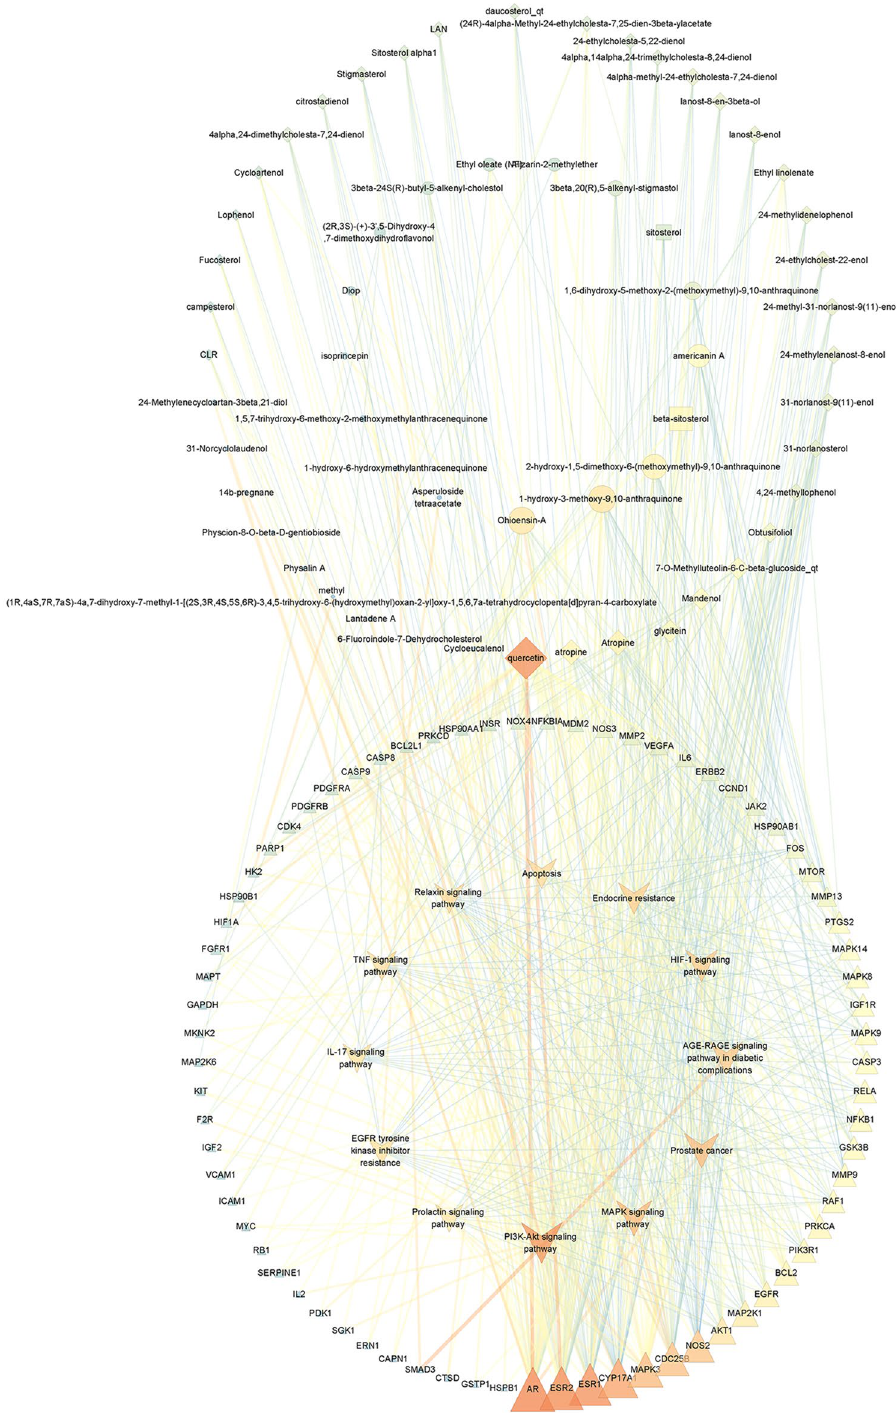
Figure 7. Core component-target-pathway network. The ellipse nodes represent ingredients from MO, and the diamond nodes represent ingredients from LB. The rectangle nodes represent beta-sitosterol and sitosterol. The triangle nodes represent the core targets from MOLBCH and OA. The V nodes represent 12 signaling pathways from enrichment analysis. The size of the circle represents the node degree of the target protein. The color scales from orange to blue indicate the value from high to low of the node degree and the edge